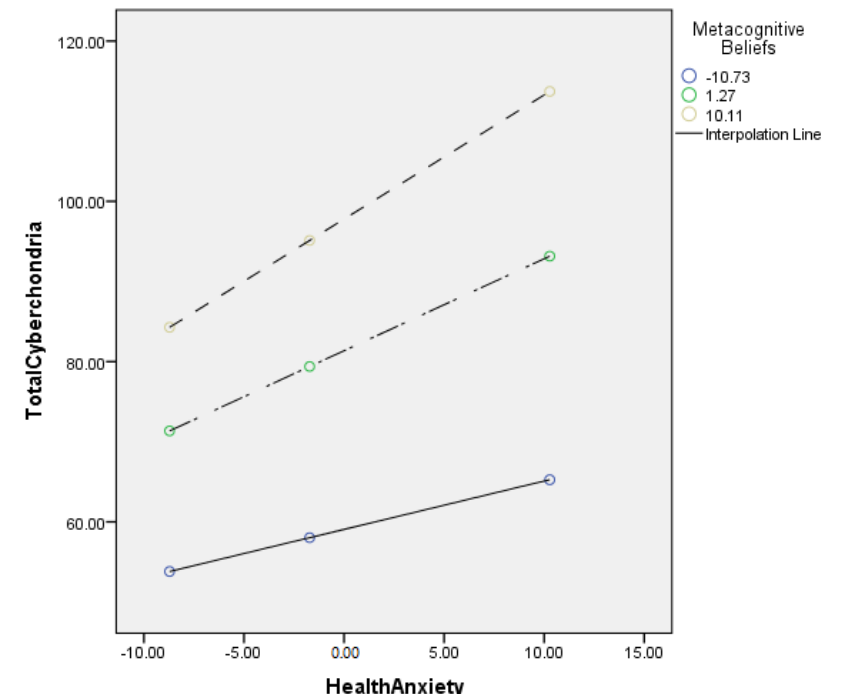
Figure 1. Graphical presentation of moderating role of metacognitive beliefs between health anxiety and cyberchondria.